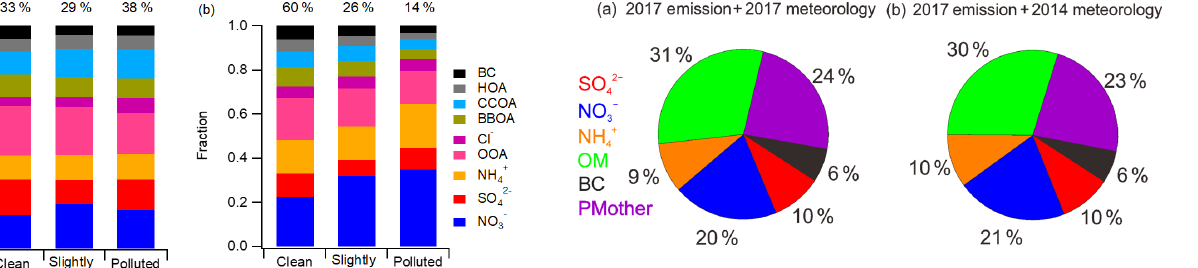
Figure 4. The average PM 2 . 5 chemical composition simulated by the WRF-CMAQ model for the observation periods in 2017: (a) base scenario with the 2017 emissions and the 2017 meteoro- logical conditions; (b) simulation with the 2017 emissions and 2014 meteorological